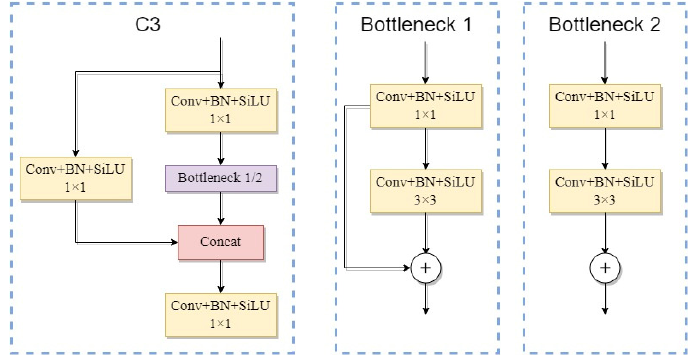
Figure 2. The diagram of C3 structure.